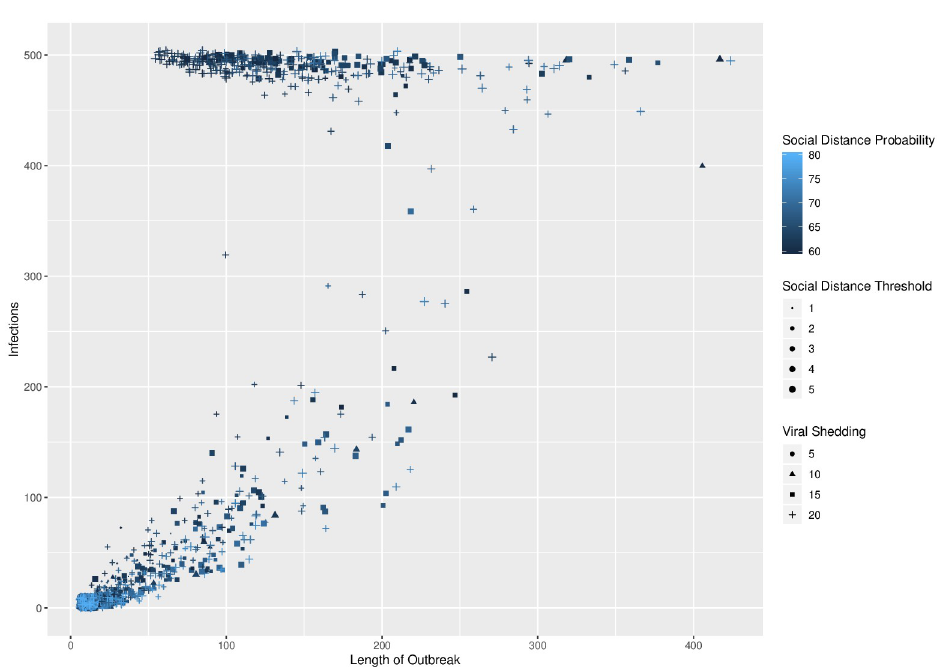
Fig 8. Total infections and length of epidemic. Length of epidemic vs. total number infected with social distance probability, social distance threshold, and viral shedding indicated by color, size, and symbol. Data from secondary